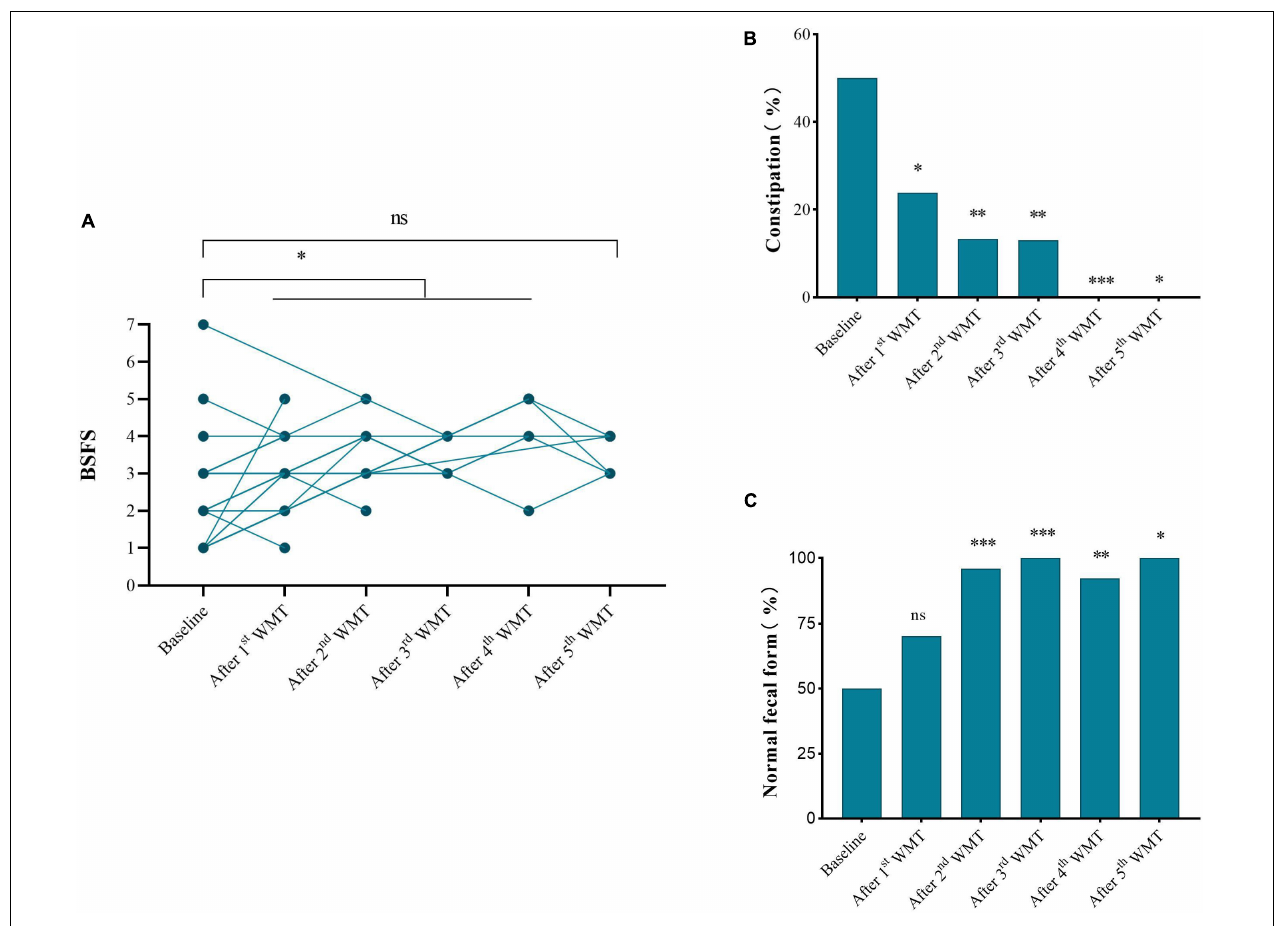
FIGURE 3 | Effect of WMT on gastrointestinal symptoms. (A) Changes in BSFS score. (B) Changes in the proportion of normal fecal form. (C) Changes in the proportion of subjects with constipation. Data from each course compared with their primary baseline. BSFS, Bristol Stool Form Scale; WMT, washed microbiota transplantation. Significance was determined using Wilcoxon signed-rank, Fisher’s exact, and Chi-square tests. ∗ P < 0.05; ∗∗ P < 0.01; ∗∗∗ P < 0.001; ns P > 0.05 not